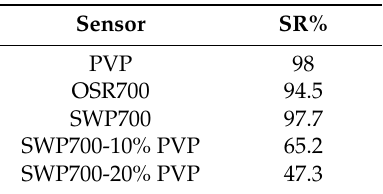
Table 4. Maximum SR% of PVP, OSR700, SWP700, SWP-10% PVP, and SWP-20% PVP sensors toward relative humidity at 26 ◦ C.